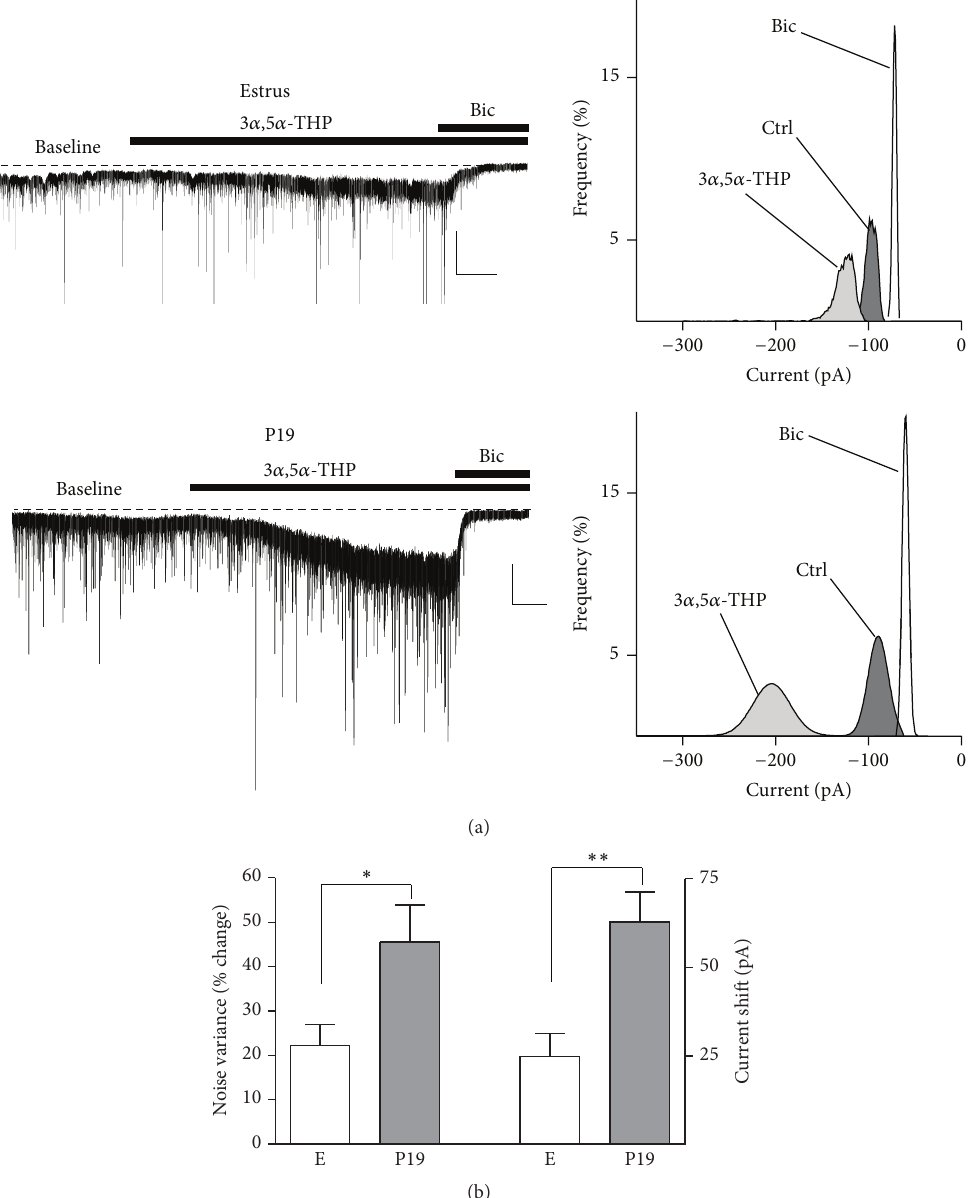
Figure 3: Modulatory action of 3 𝛼 ,5 𝛼 -THP on tonic GABAergic current in granule cells of the dentate gyrus during pregnancy. (a) Representative traces (left) and all-points histogram (right) of GABAergic currents recorded from granule cells in hippocampal slices from ratsin estrusor at P19. Theeffect of 3 𝛼 ,5 𝛼 -THP (1 𝜇 M)and bicuculline (30 𝜇 M)is reported. (b) Bargraph summarizing thepercentage changes in noise variance (left y -axes) and holding current (right y- axes) induced by 3 𝛼 ,5 𝛼 -THP in experiments similar to those shown in (a). Adapted from Sanna et al., 2009